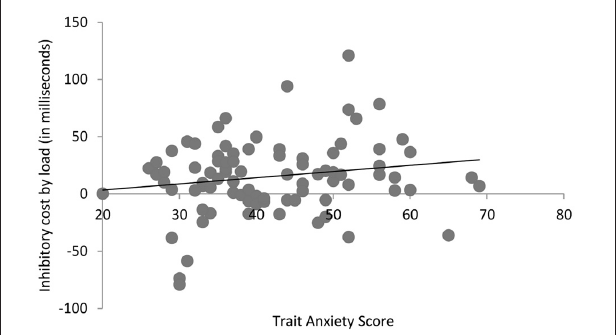
FIGURE 2 | Correlation between trait anxiety score and load-induced inhibitory costs on saccadic